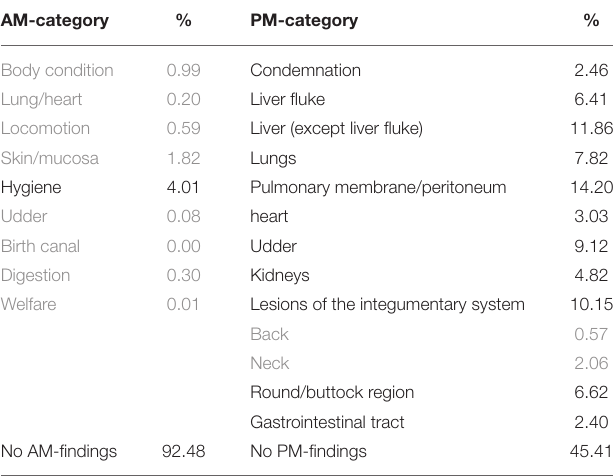
TABLE 3 | Mean yearly percentage of slaughtered cattle with an AM- or PM-finding per category in one large Dutch slaughterhouse between January 1, 2015 and September 30, 2018. Categories that were not further analyzed are displayed in gray. N = 125.006 slaughtered cattle per year.